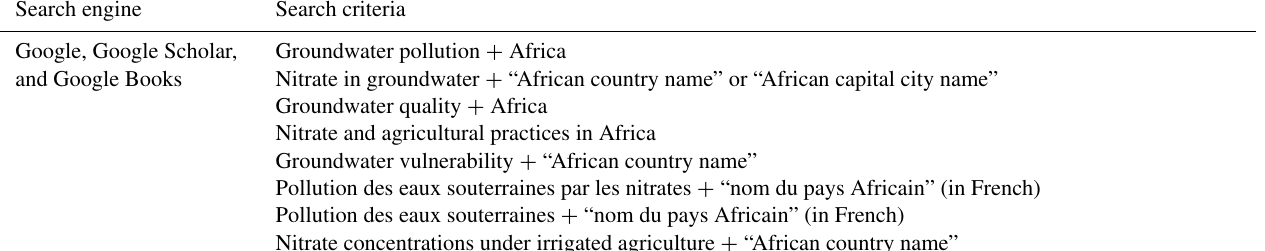
Table 1. Criteria used to identify nitrate data studies within web databases. Search